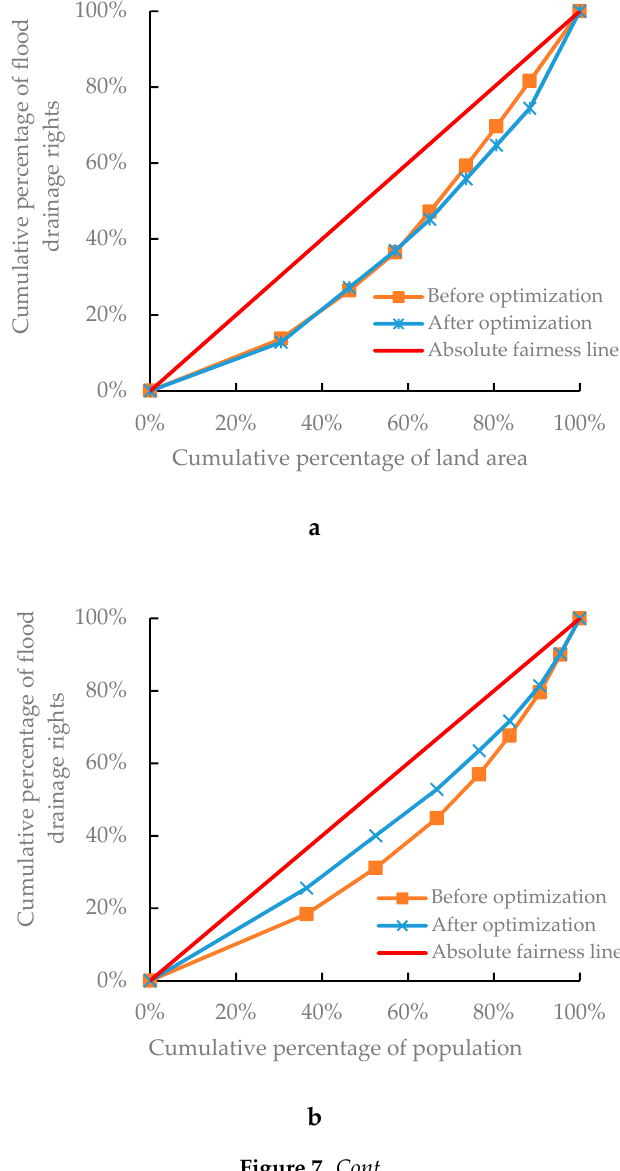
Table 10. Optimization results of environmental Gini